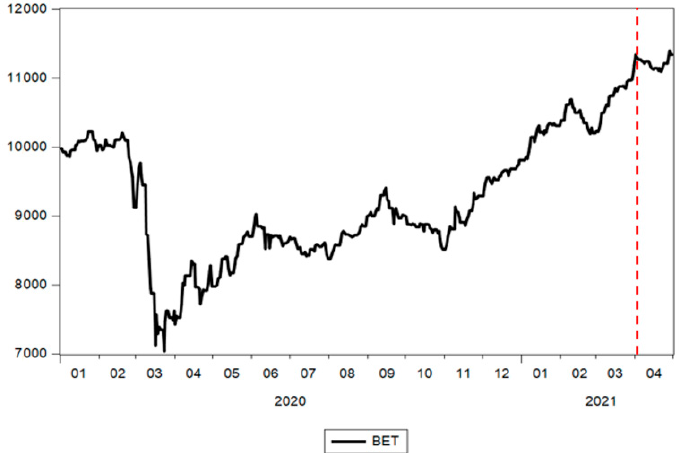
Figure 3. Evolution of the BET index. Source: authors’ contribution using EViews 10 software (IHS Global Inc., Irvine, CA, USA).